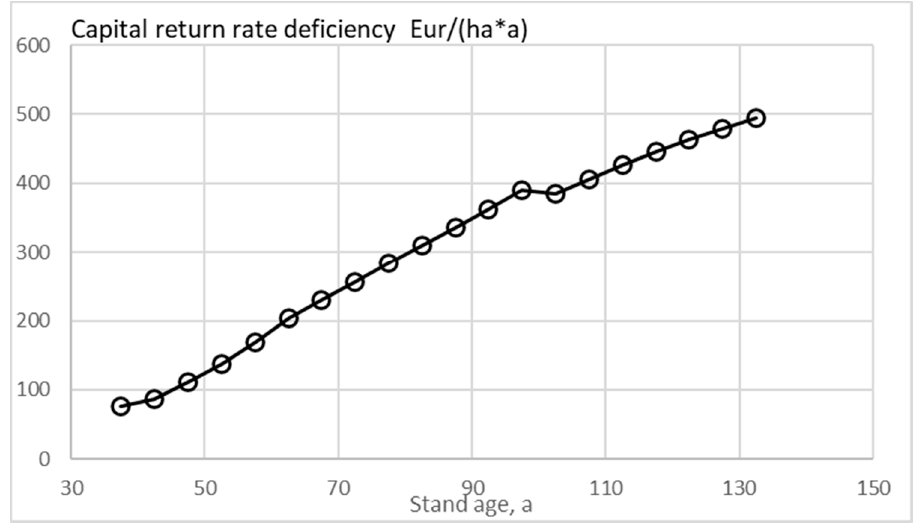
Figure 14. Capital return rate deficiency in Euros per hectare and year, with thinnings from below.